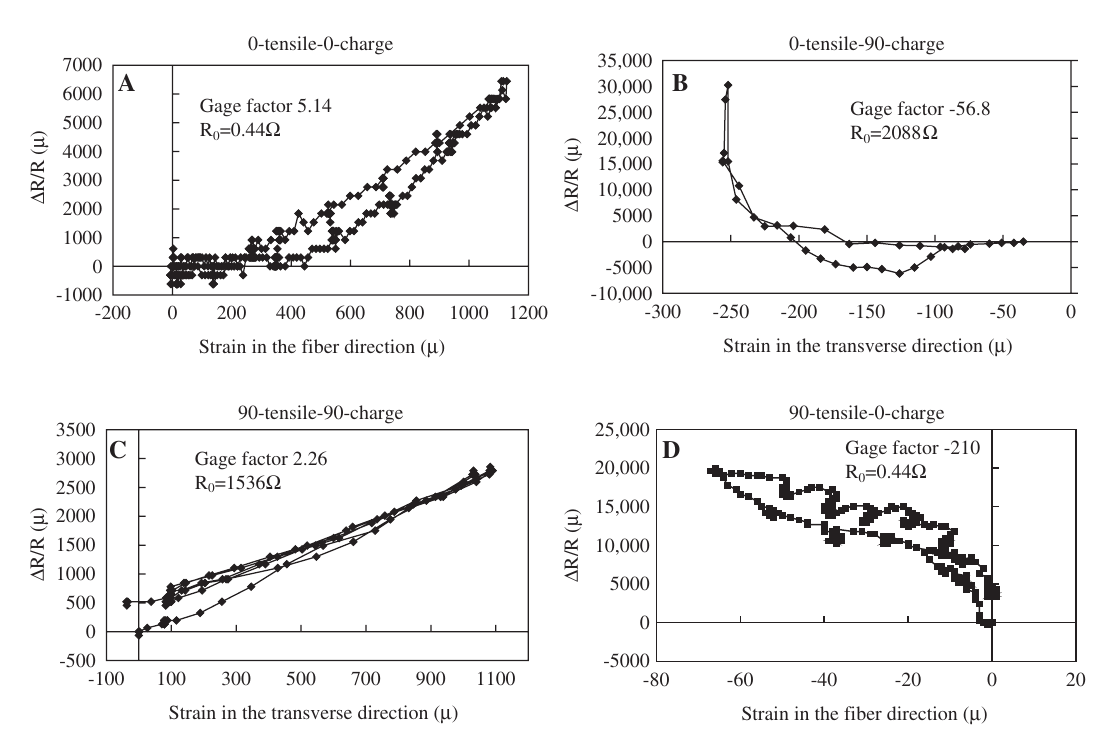
Figure 3 Measured piezoresistance of the single ply specimen from a tensile test in the elastic deformation region.